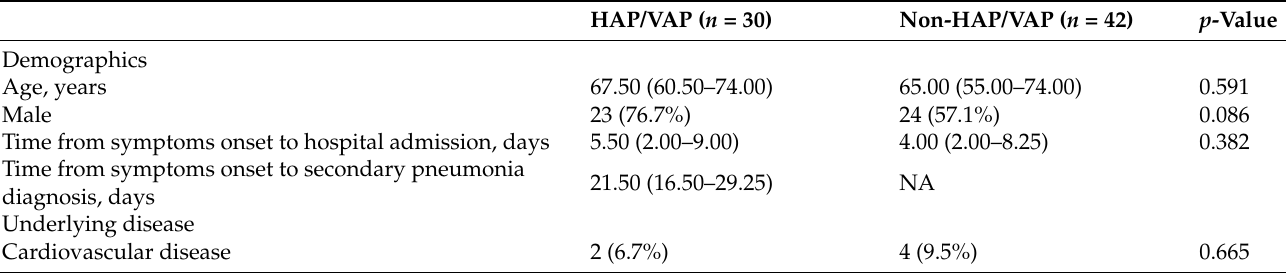
Table 1. Clinical characteristics of patients according to the HAP/VAP